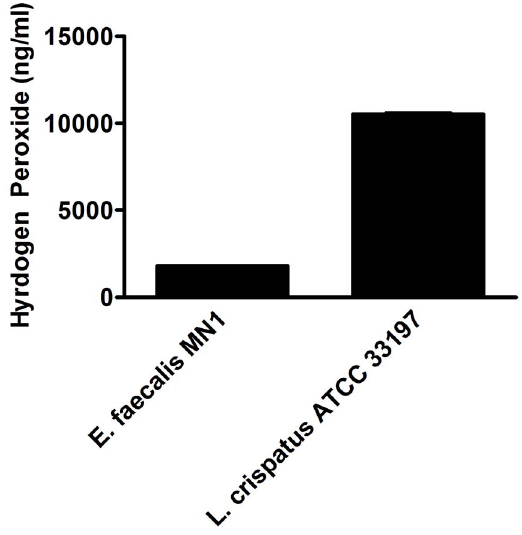
Figure 4. E. faecalis MN1 makes low levels of hydrogen peroxide. E. faecalis MN1 and L. crispatus ATCC 33197 were grown overnight in KSFM tissue culture medium. Hydrogen peroxide production was measured using a H 2 O 2 colorimetric detection assay